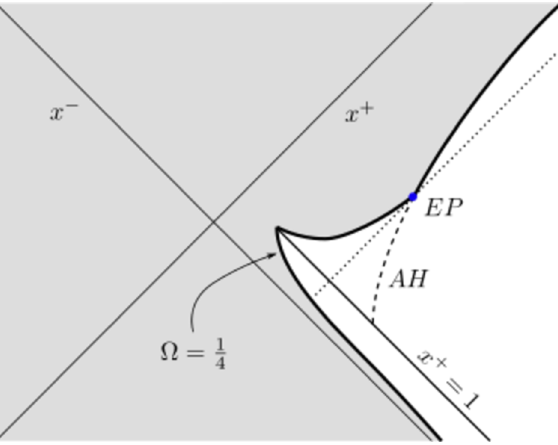
Figure 2 . Evaporating black hole in Kruskal coordinates. The apparent horizon AH is on the dashed line and the evaporation endpoint is marked EP . The dotted line prior to EP is the event